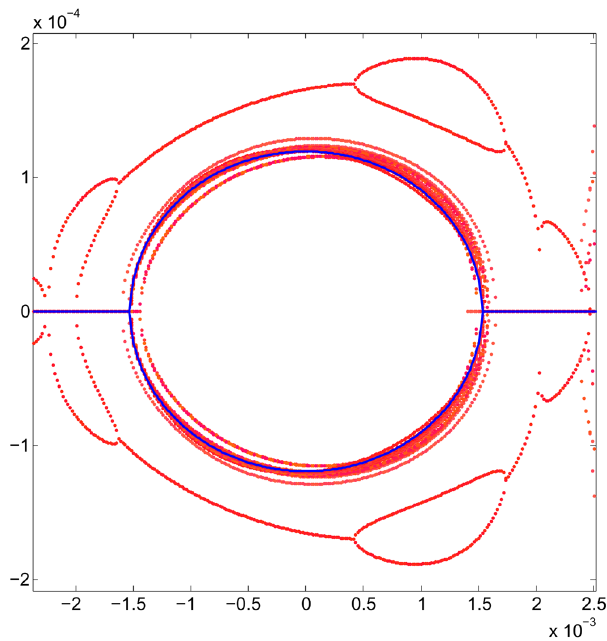
Figure 6. Phase space ( x , p x ) showing the original resonances and, in greater detail than in Fig. 5, the behavior of the inner real roots (in red) trying to fit the ellipse (blue) of linear dynamics, under the optimization process of the objective function. Units in the plot are